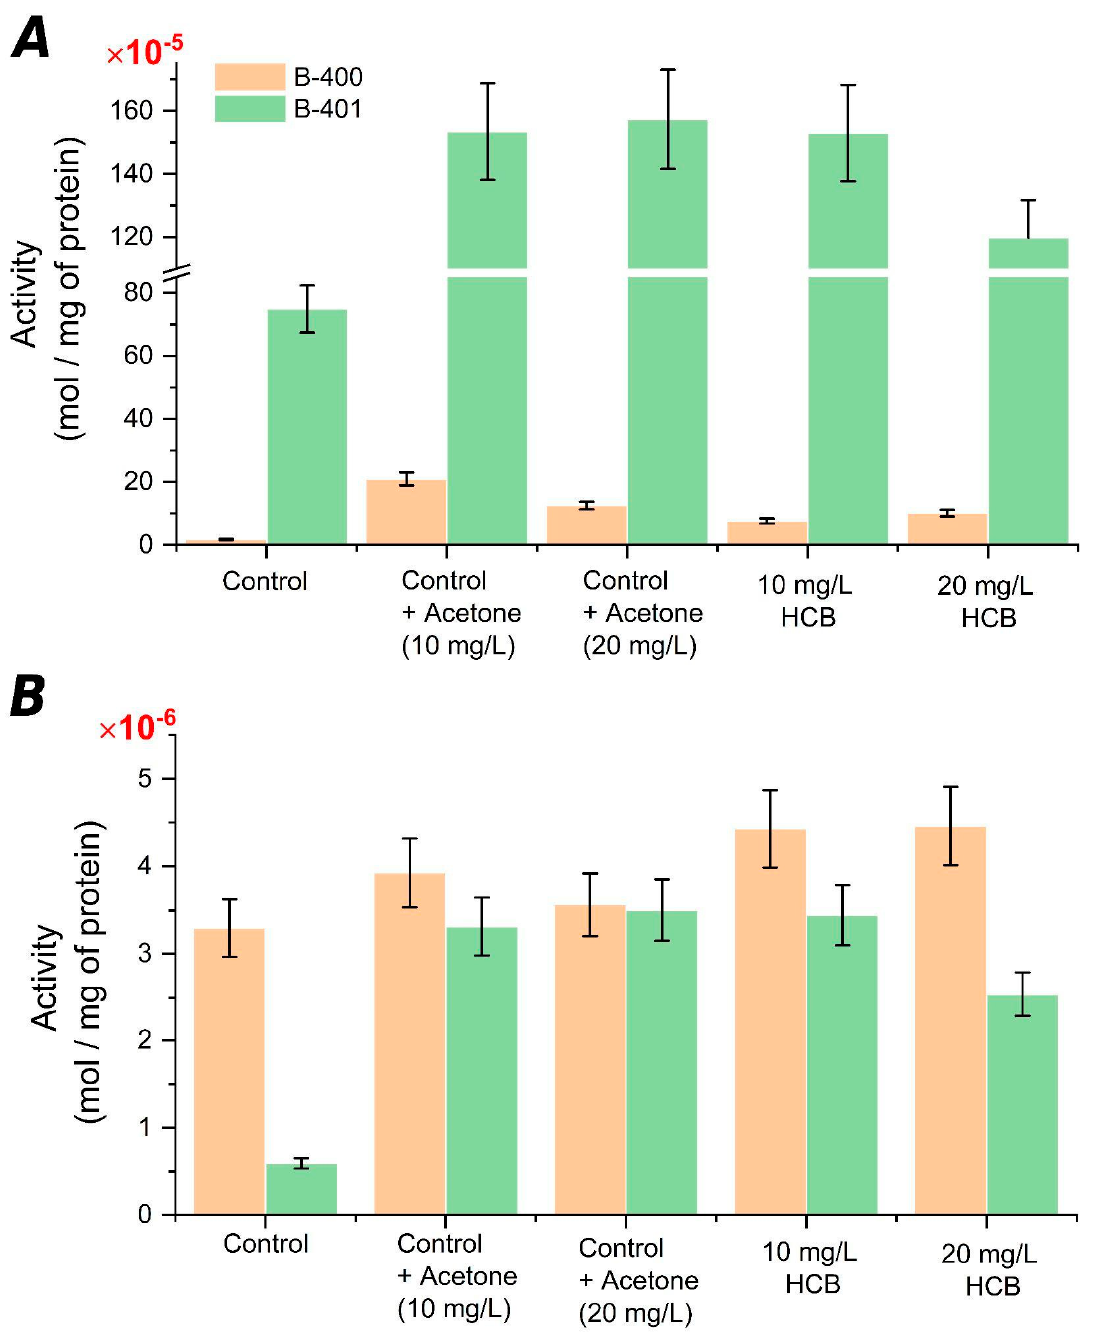
Figure 3. Antioxidant enzymatic activity of Comamonas testosteroni strain B-400 and strain B-401: catalase ( A ) and peroxidase ( B ).